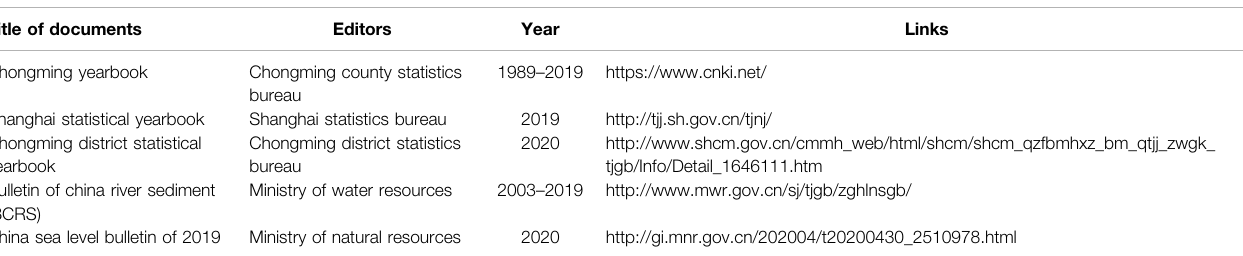
TABLE A2 | The main online data set related to Chongming Island, river sediment of Yangtze River and sea level of